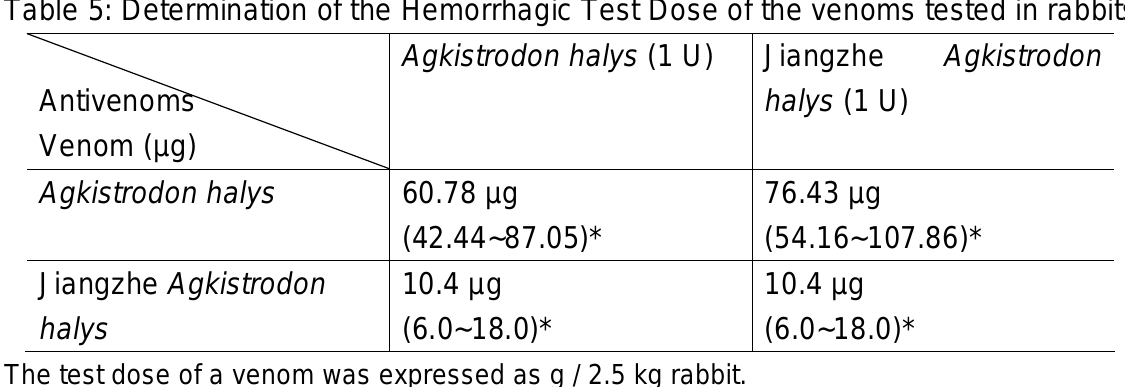
Table 6: Results of the antihemorrhagic potency (AHP) test of Agkistrodon halys and Jiangzhe Agkistrodon halys antivenoms against Agkistrodon halys venom containing 83 µg (47 MHD) of the test